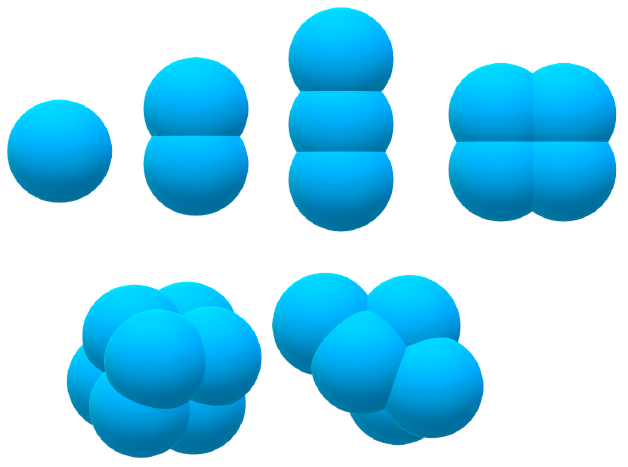
Figure 7. Different associations of spherical DEM particles used to more realistically account for the effects of soil particle shape on bulk behaviour.